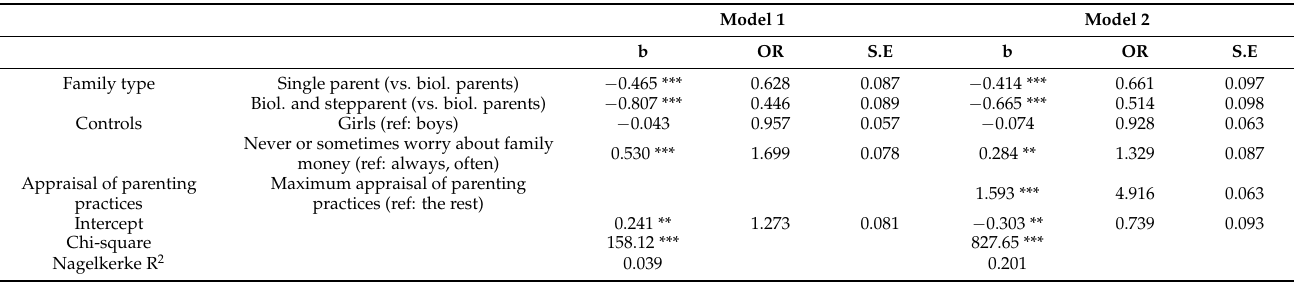
Table 3. Binary logistic regression models explaining those children “totally satisfied” with people they live with (ref: the rest). Model 1 Model 2 b OR S.E b OR